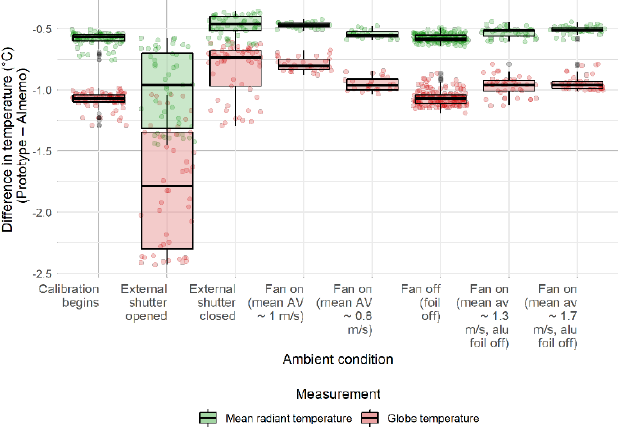
Figure A6. Difference in globe (tg) and mean radiant temperature (mrt) recorded by the Arduino prototype and Almemo instrument during various ambient conditions.